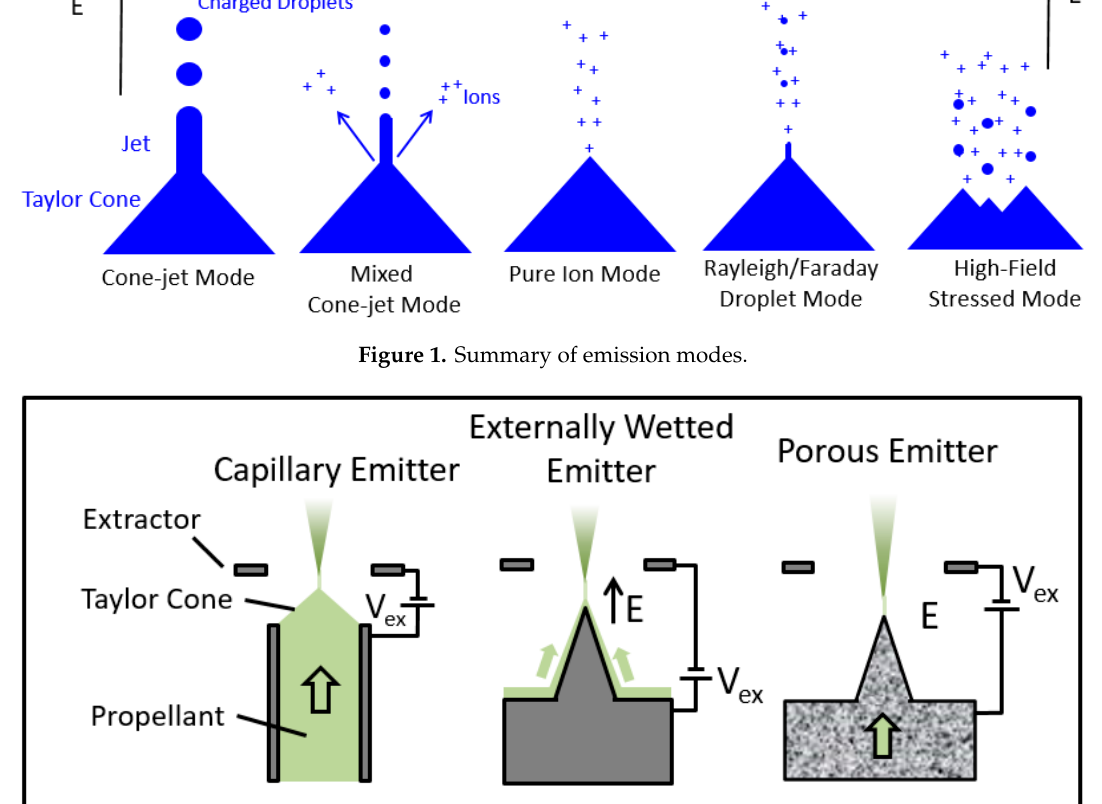
Figure 2. Summary of emitter configurations supported in the Electrospray Propulsion Engineering Toolkit (ESPET). Externally and porous emitters can be either conical (axisymmetric) or edge/ridge designs. E is the electric field and V ex is the extraction voltage.